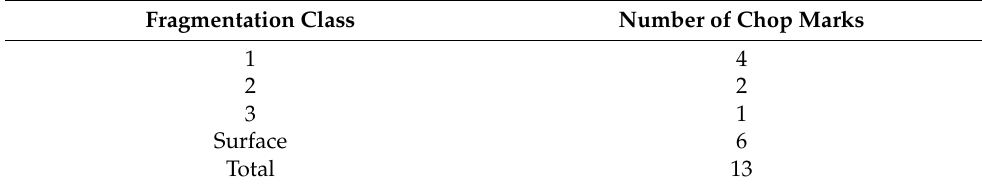
Table 4. Frequency distribution of experimental chipped stone axe chop marks by Fragmentation